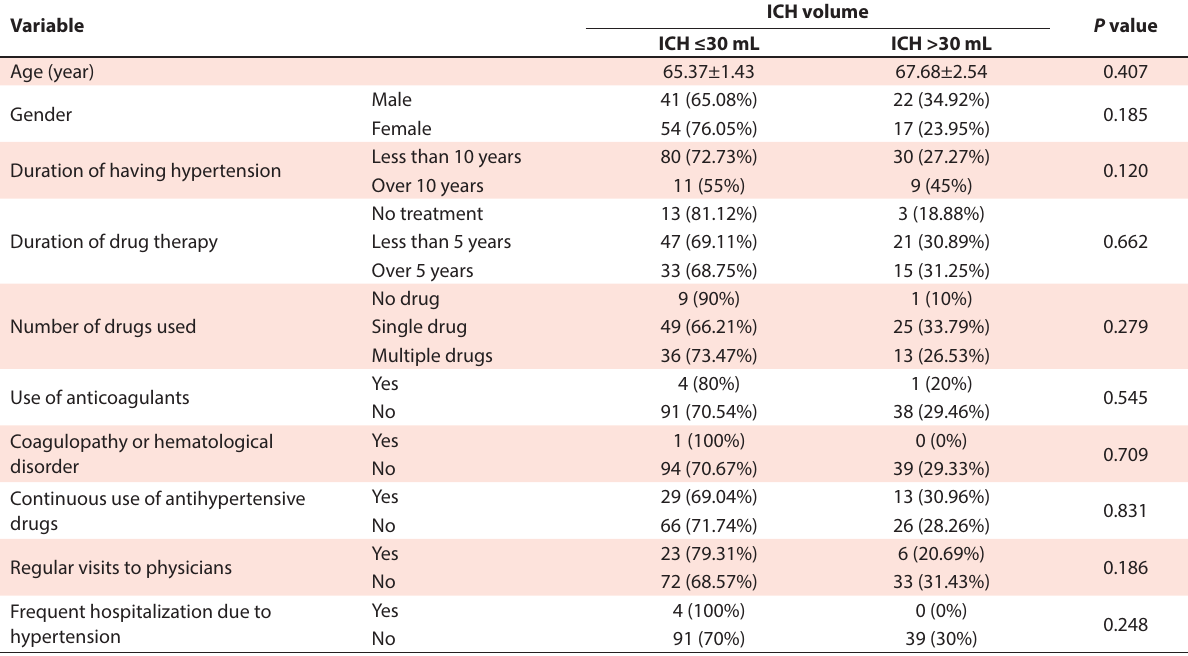
Table 1. Relationship between ICH volume and demographic and clinical factors